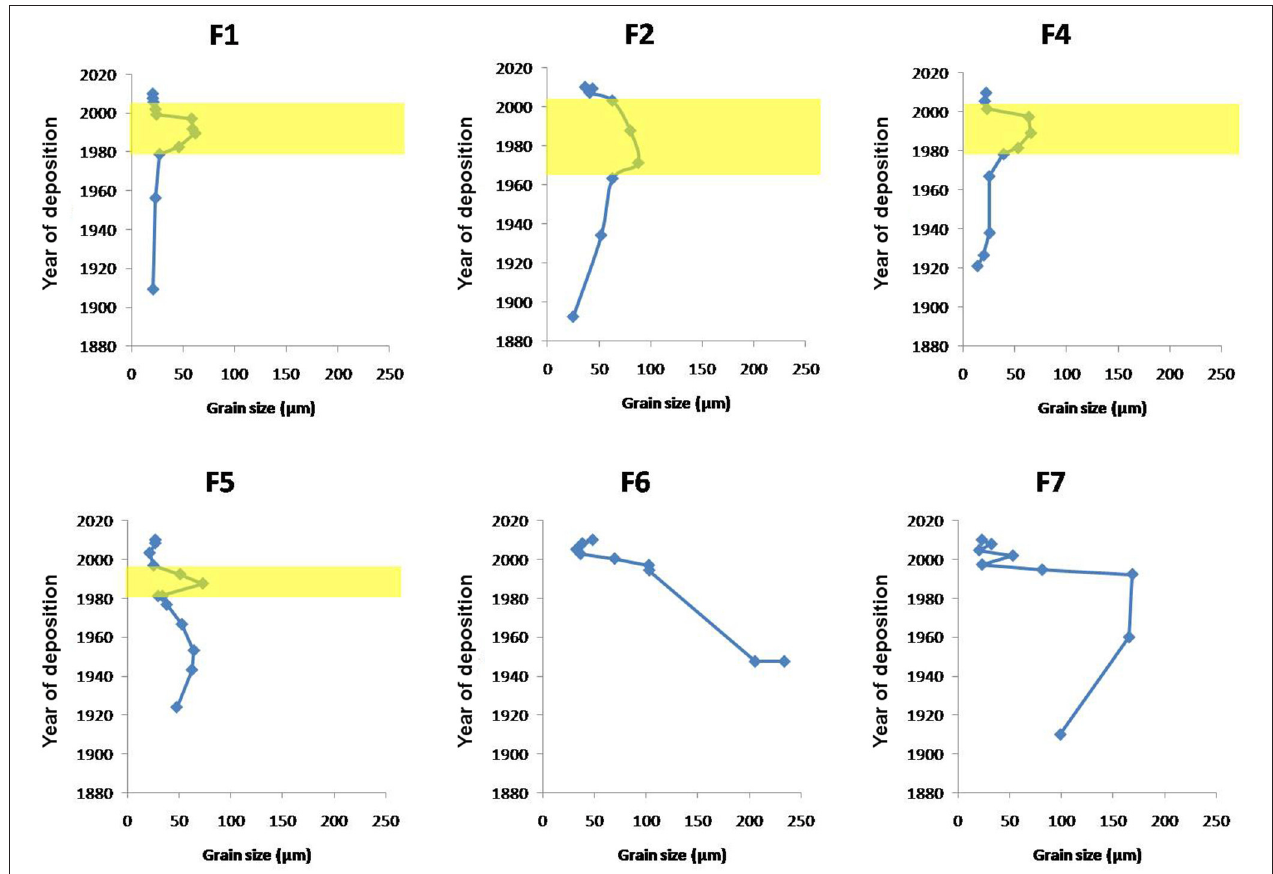
FIGURE 8 | Median grain sizes ( µ m) of the sediment in the cores F1, F2, F4, F5, F6, F7 plotted against the respective age of the sediment layer. Distinct coarse grained zones within the cores are indicated by horizontal yellow bars. Due to the lack of fine sediments below 2cm, no datings are available for core